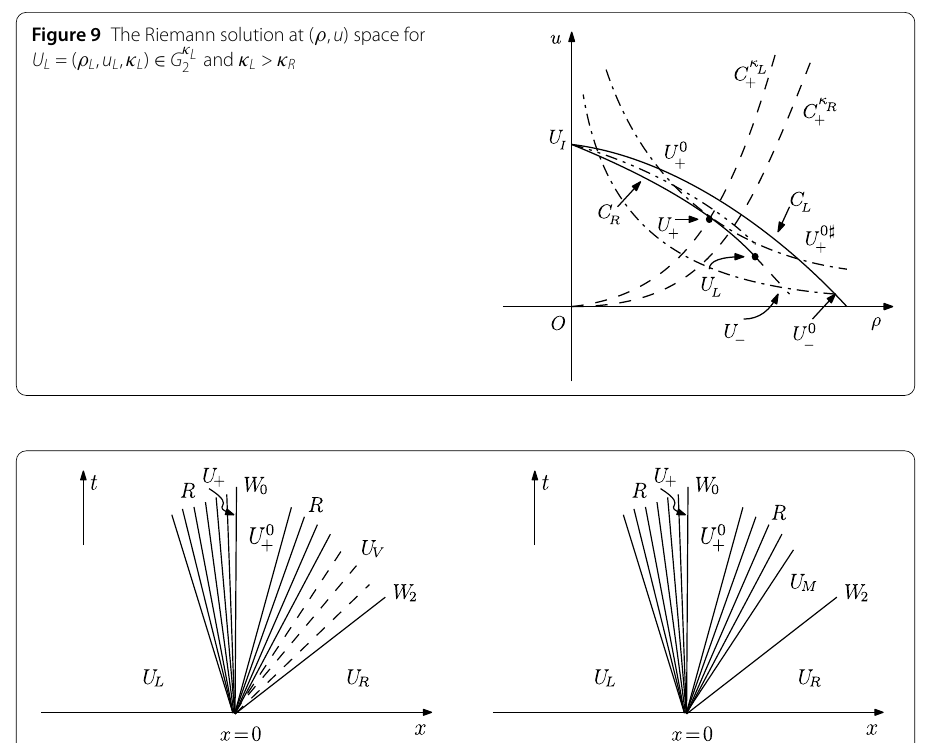
Figure 10 The Riemann solution at ( x , t ) space for subcases (B1) (left) and (B2) (right), respectively